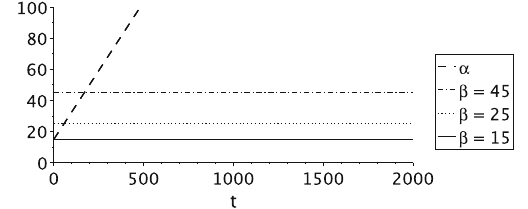
Fig. 5 The second extra space is constant for wide range of the ini- tial metric β( 0 ) > 11. The parameter values k = − 2 , a = − 3 , c = − 0 . 1875.Theinitialvalues α( 0 ) = 15 , ˙ α( 0 ) = H (cid:4) 0 . 17678 , ˙ β( 0 ) = 0 , ˙ R ( 0 ) = 0 . R ( 0 ) (cid:4) 0 . 375 is found from Eq.